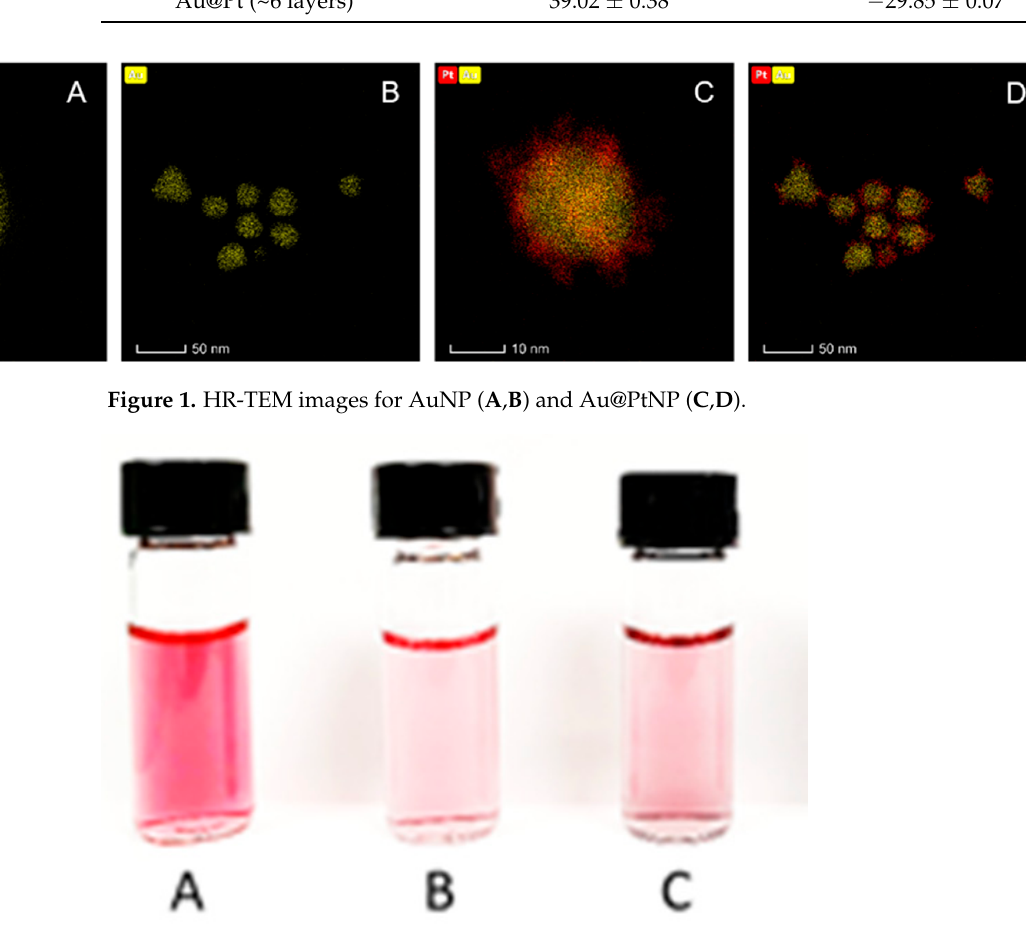
Figure 2. Digital image of synthesized AuNPs ( A ), Au@Pt–monolayer ( B ) and Au@Pt–multilayer ( C